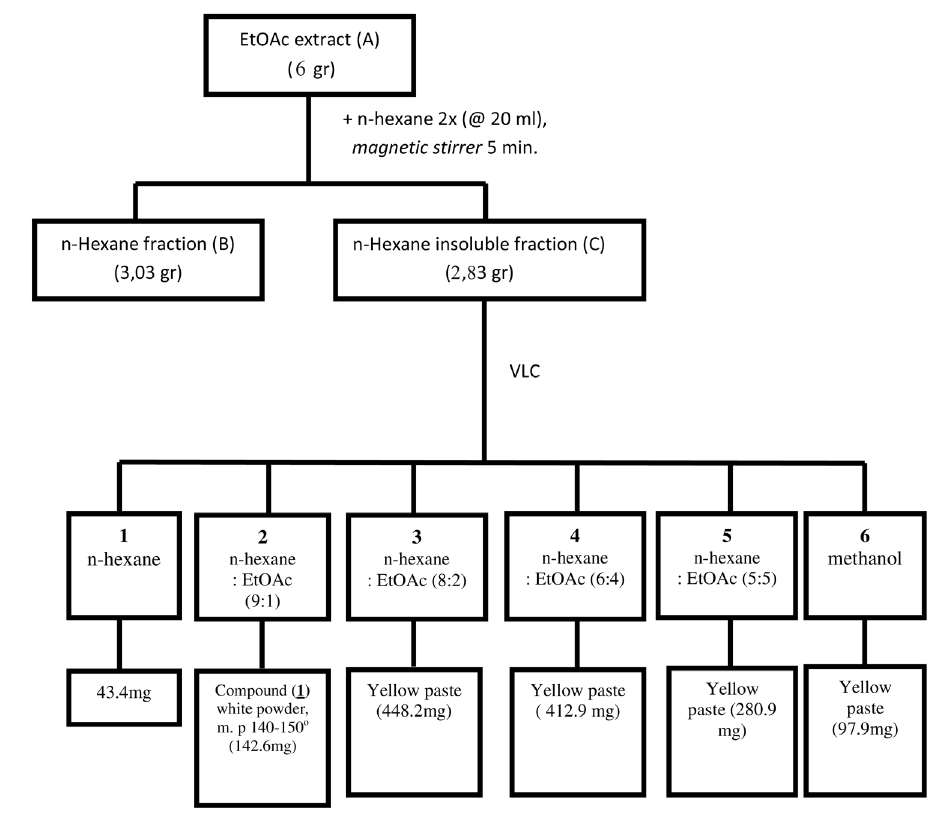
Figure 1. Isolation process of cytotoxic compound 1 (subfraction 2) from Lansium domesticum fruit peels.